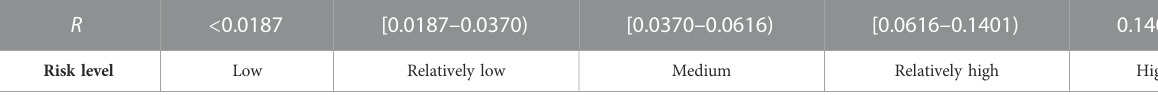
TABLE 10 Tropical cyclone hazard classi fi cation for Donghaitang wind farm.